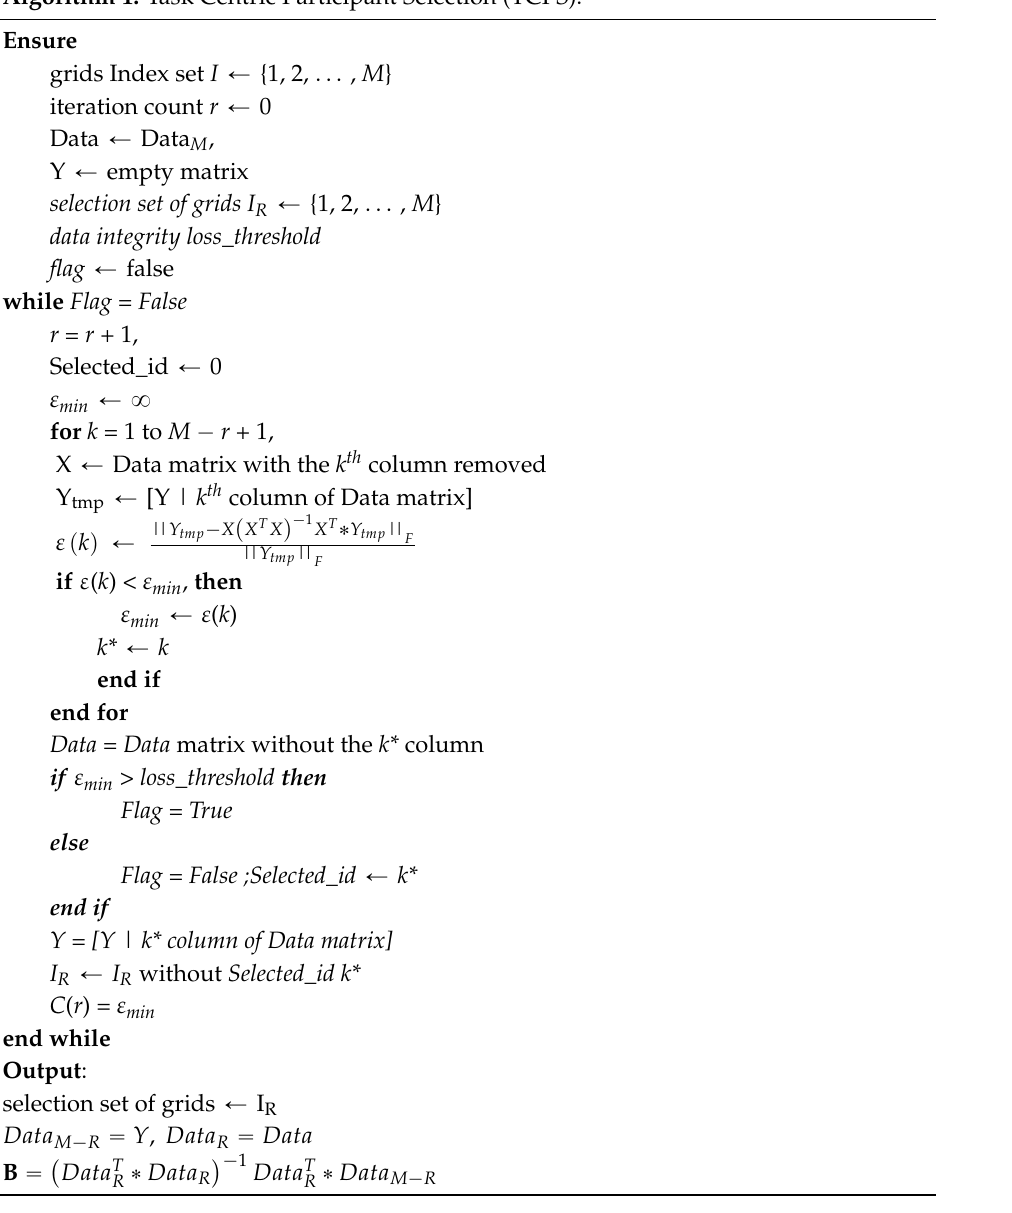
Algorithm 1: Task Centric Participant Selection